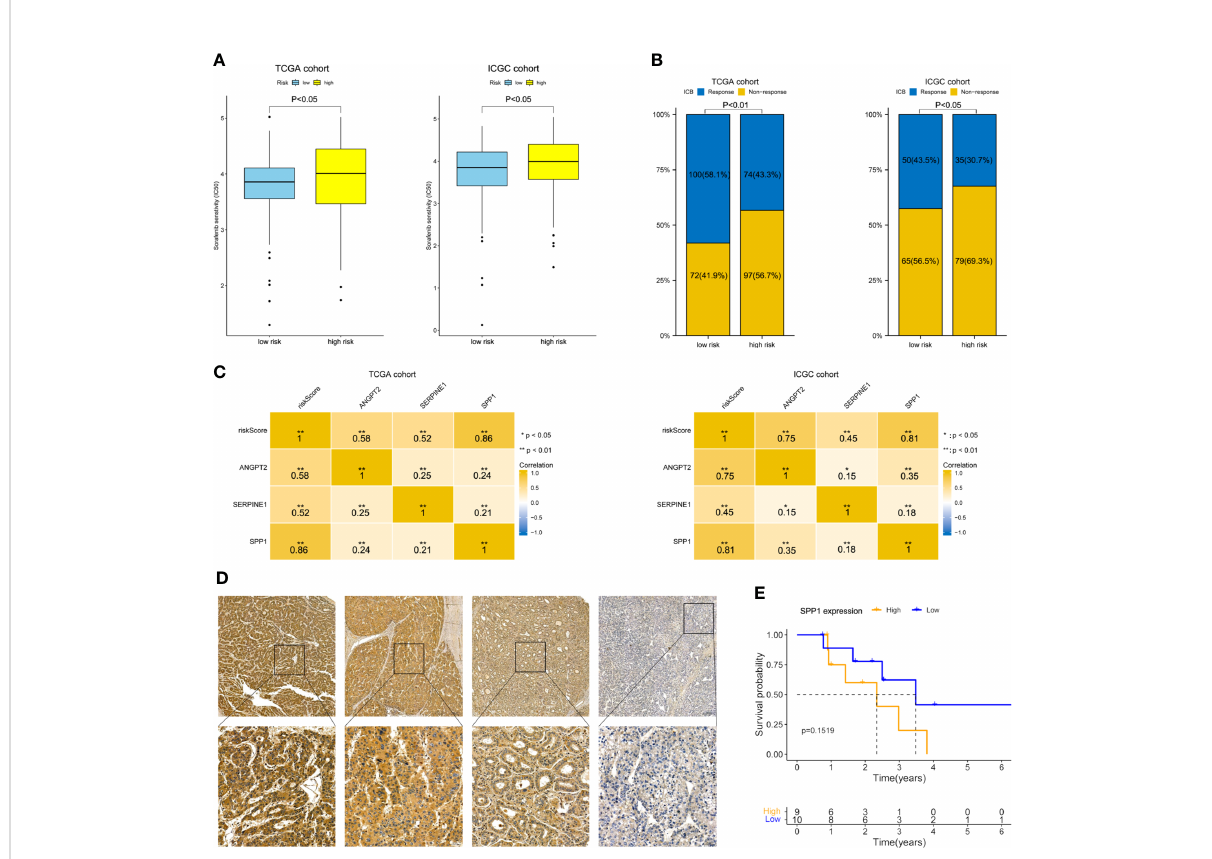
FIGURE 8 Therapeutic response prediction and immunohistochemistry of SPP1. (A) Sensitivity to sorafenib by risk group. (B) Response rate to ICB therapy. (C) Heatmap showing the correlation between risk score and the three model genes. (D) Representative immunohistochemically stained images of HCC tissues showing SPP1 expression (upper, 5.0×; lower, 20.0×). (E) K-M OS curves of 19 HCC patients with different SPP1